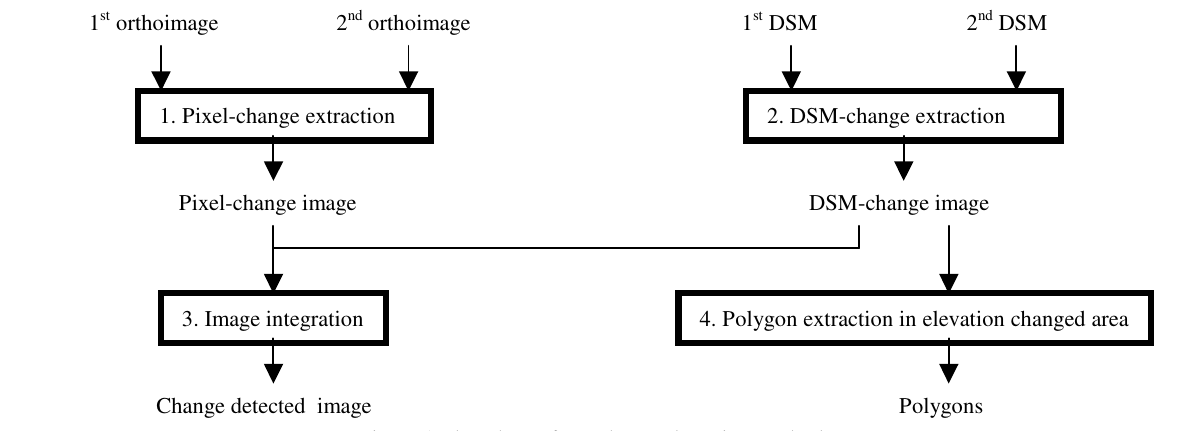
Figure 1:Flowchart of our change detection